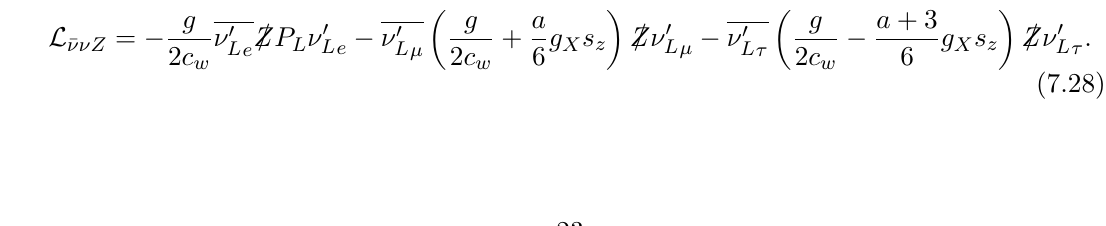
Figure 1 . Summary of constraints on the X = Y 3 + a the g vs. a plane, for two values of the 23 down-type quark mixing angle θ X /M Z 0 the white region between the dashed line contours is allowed at 95% CL. In addition to the band that fits the NCBAs, we show the constraints ( 95% CL) from B ρ -parameter. For the larger value of the mixing angle (right-hand plot), the B s − ρ -parameter constraints are of a similar strength, allowing one to access the widest range of values for the parameter a . In figure 2 we also show the constraint on the gauge coupling from requiring perturbative